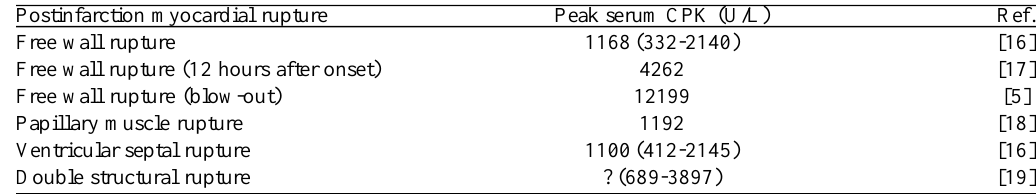
Table 5. Peak serum CPK levels of postinfarction myocardial rupture patients reported previously. Postinfarction myocardial rupture